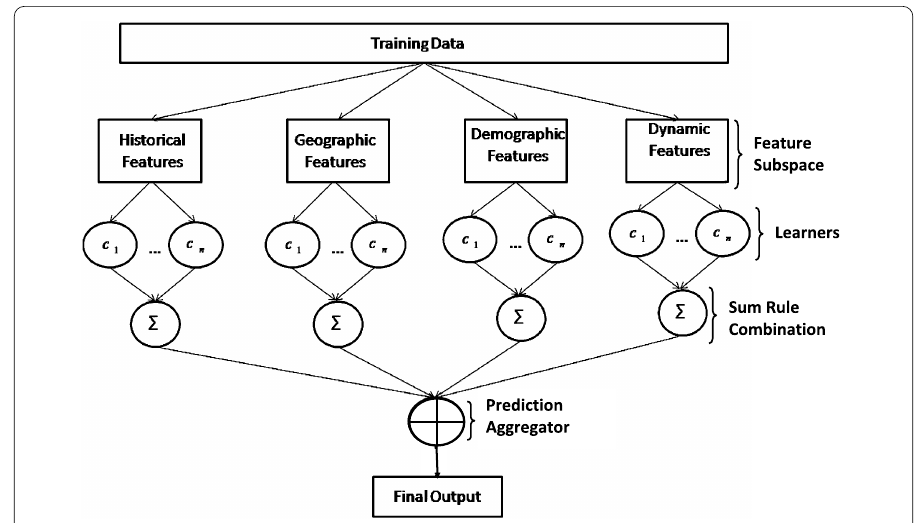
Figure 6 Ensemble model for crime event prediction